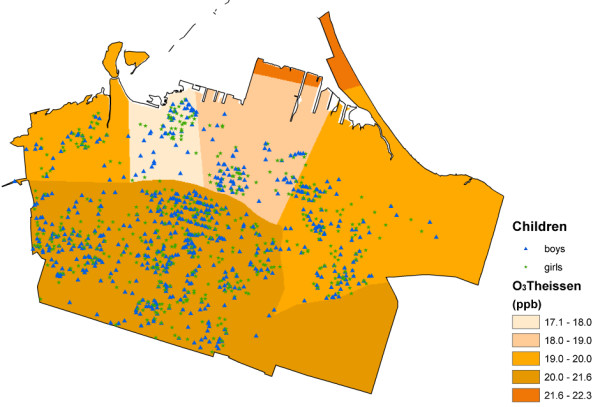
O3Theissen surface.